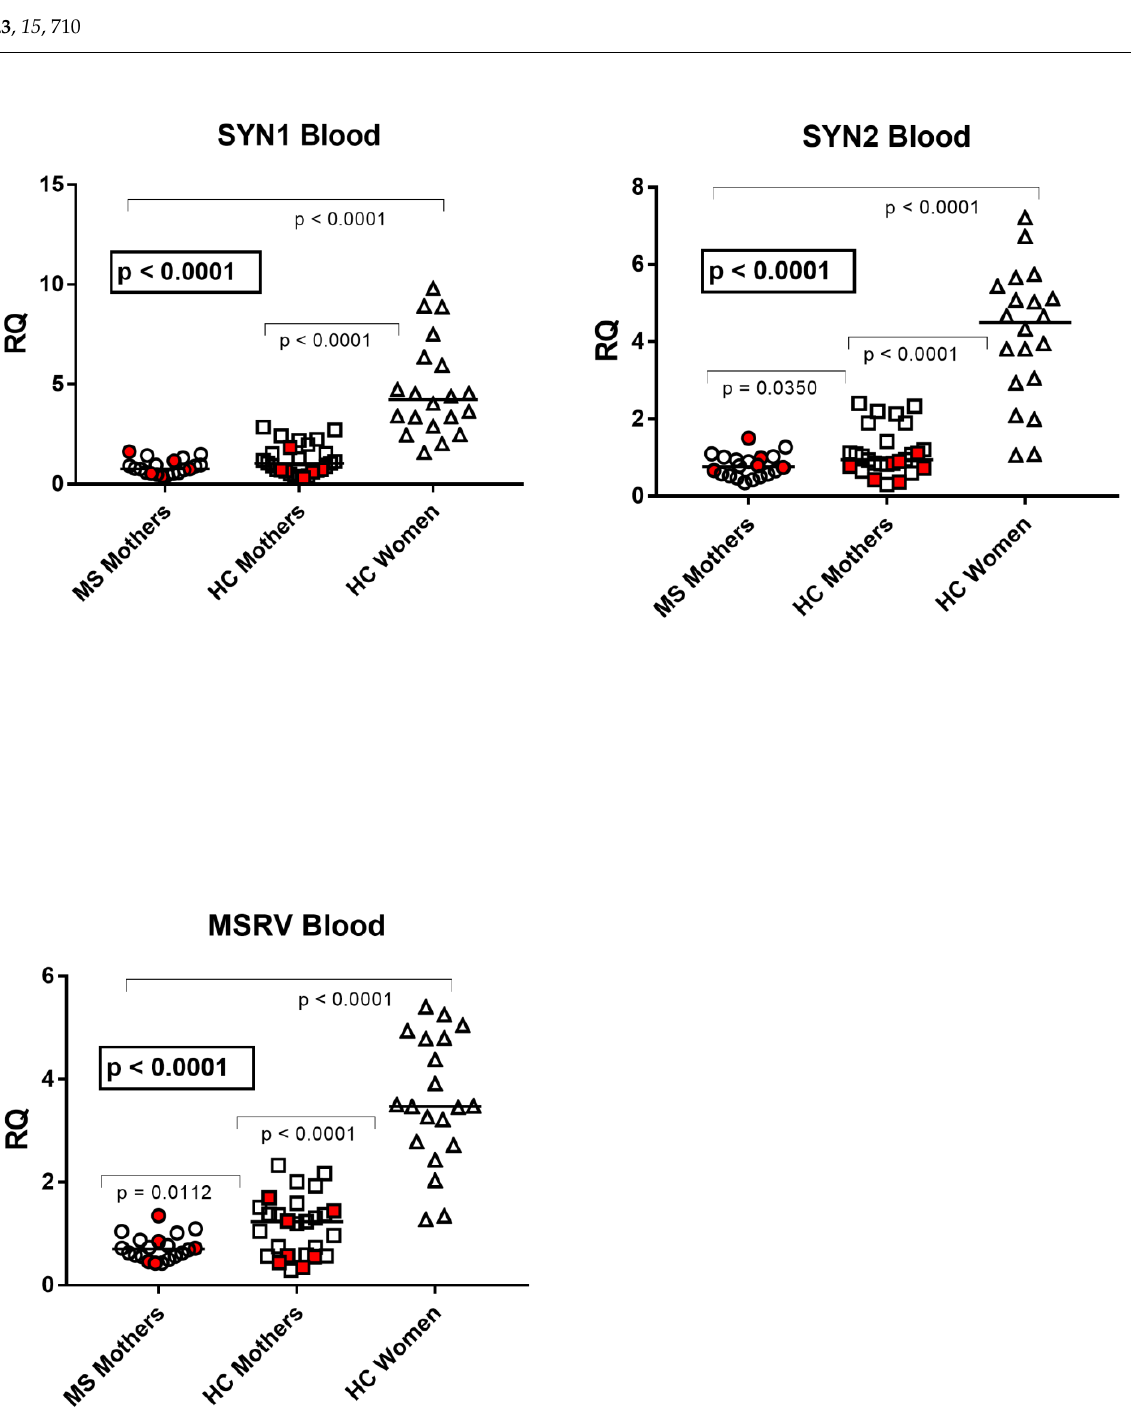
Figure 2. Expression of env genes of Syncytin (SYN) 1, SYN2, and of multiple-sclerosis-associated retrovirus (MSRV) in peripheral blood from 20 mothers with multiple sclerosis (MS), 27 healthy control (HC) mothers, and 20 nonpregnant healthy women of child-bearing age. RQ: relative quantification. Circles, squares, and triangles show the mean of three individual measurements; horizontal lines show the median values. Premature deliveries are in red. Medians and IQR 25 – 75%: SYN1- env : Group A (mothers with MS) 0.77, 0.56 – 1.01; Group B (unaffected mothers) 1.05, 0.68 – 1.69; Group C2 (nonpregnant women) 4.23, 3.24 – 6.04; SYN2- env : Group A 0.76, 0.56 – 0.99; Group B 0.94, IQR 0.80 – 1.31; Group C2 4.50, IQR 3.02 – 5.20; MSRV- env : Group A 0.70, IQR 0.56 – 0.85; Group B 1.23, IQR 0.58 – 1.48; Group C2 3.47, 2.77 – 4.48.